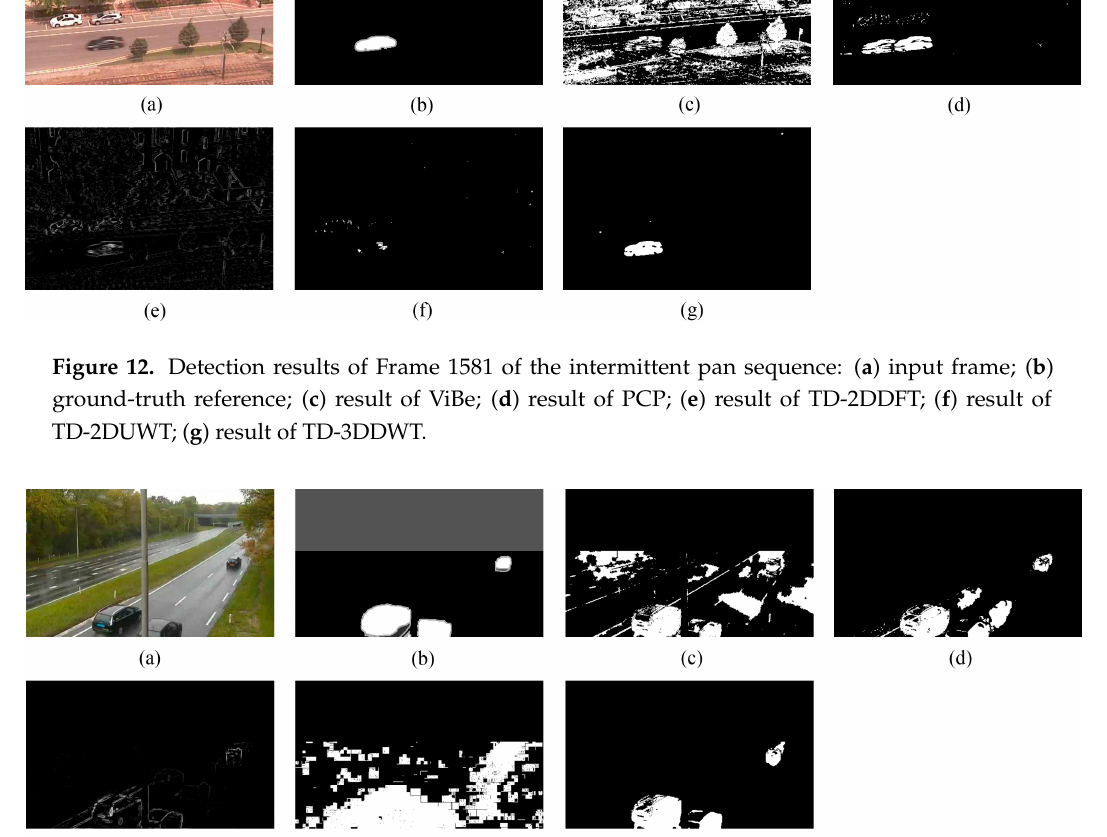
Figure 13. Detection results of Frame 1215 of the two-position pan-tilt-zoom (PTZ) camera sequence: ( a ) input frame; ( b ) ground-truth reference; ( c ) result of ViBe; ( d ) result of PCP; ( e ) result of TD-2DDFT; ( f ) result of TD-2DUWT; ( g ) result of TD-3DDWT.